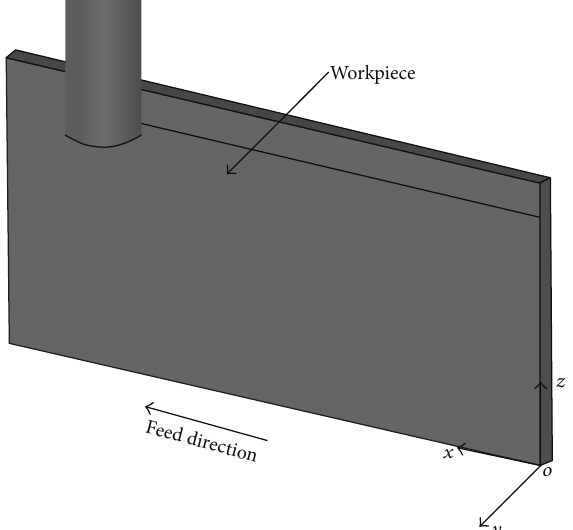
Figure 2: Schematic diagram of milling process.